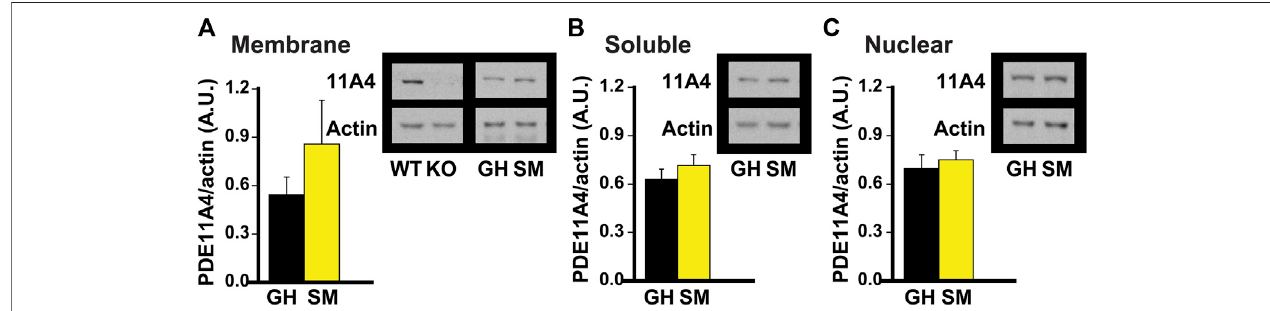
FIGURE2| ChronicsocialisolationduringadolescencedoesnotchangePDE11A4proteinexpressioninventralhippocampalfractions.Adolescentgroup-housed mice (GH) demonstrate equivalent ventral hippocampal PDE11A4 protein expression (98kD) relative to isolated mice (single-housed for 1 month, SM; n (cid:2) 6 samples/ group/sex) in the (A) membrane fraction (effect of group: F (1,9) (cid:2) 1.08, P (cid:2) 324), (B) soluble fraction (effect of group: F (1,9) (cid:2) 0.04, P (cid:2) 0.838), and (C) nuclear fraction (effect of group: F (1,9) (cid:2) 0.73m O (cid:2) 0.411). Note that samples from the hippocampi of a Pde11a wildtype (WT) and knockout (KO) mouse were included as a positiveand negativecontrol, respectively, for thePDE11A4antibody. Dataareplottedas means ± SEMs. Brightness and contrastofblot images adjusted forgraphical clarity.